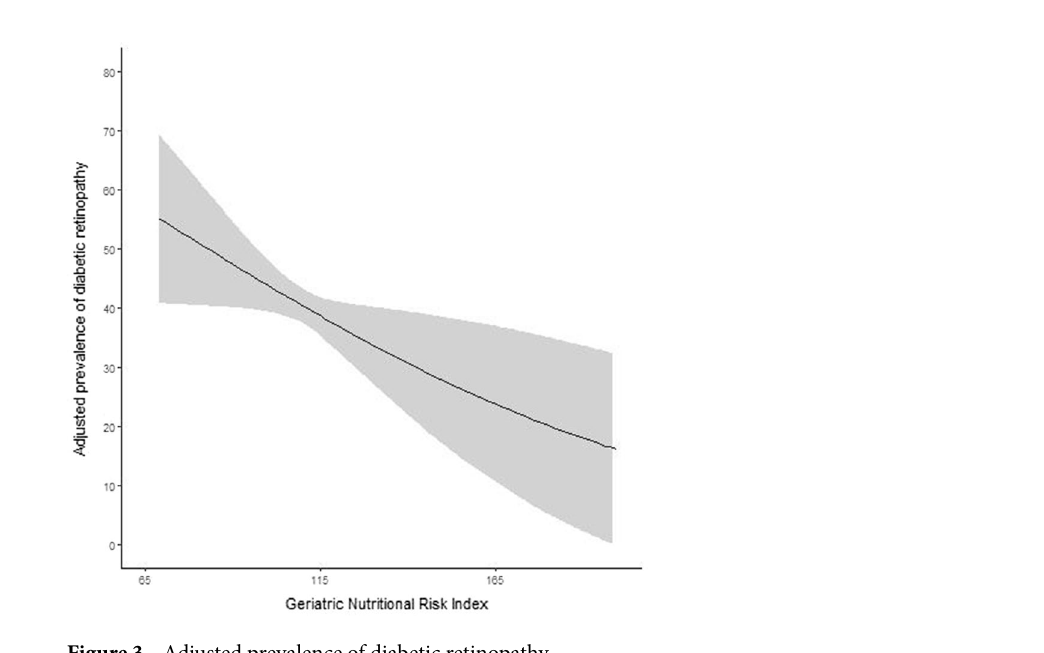
Figure 3. Adjusted prevalence of diabetic